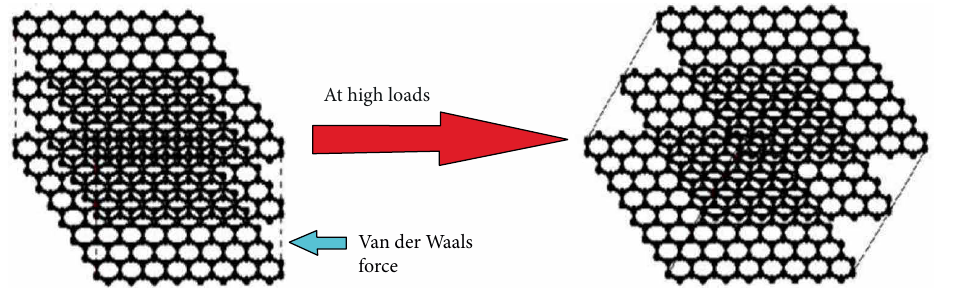
Figure 12: Illustration of shearing of GNPs at high load (2300 N) for 1.0%